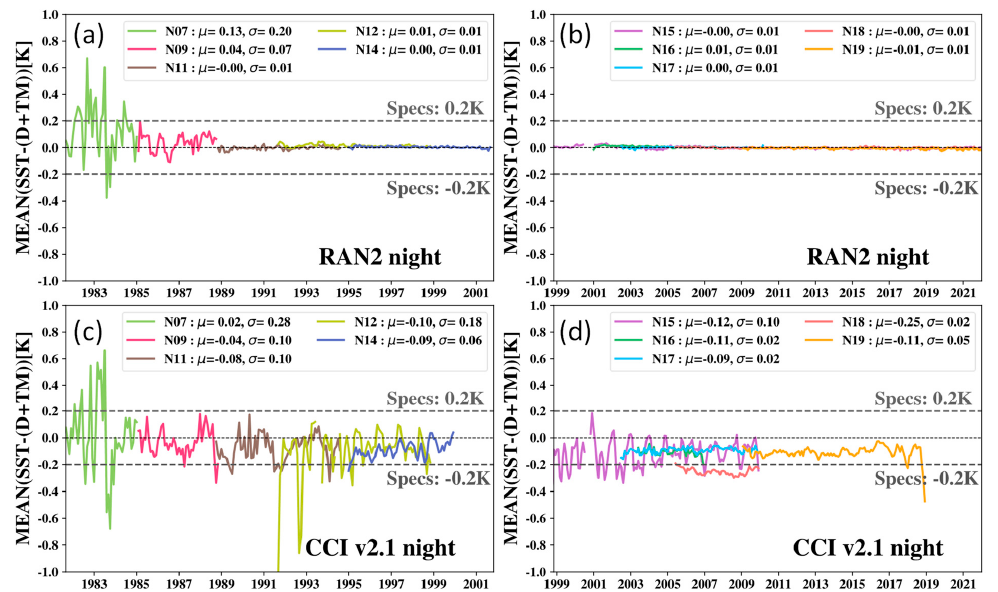
Figure 16. Global monthly nighttime biases with respect to (D + TM) for ( a , b ) RAN2 ‘depth’ SST and ( c , d ) CCI ( a , c ) AVHRR/2s; ( b , d ) AVHRR/3s. (Data are from the NOAA SQUAM system [21,22].)